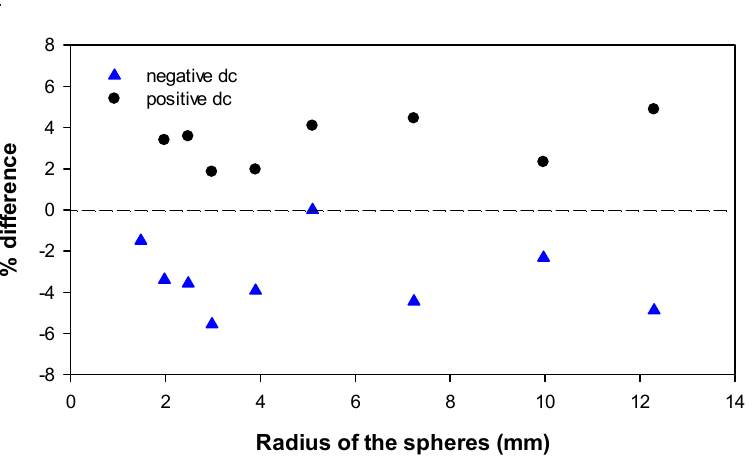
Table 4. Regression parameters of E c = b · ( 1 + c /